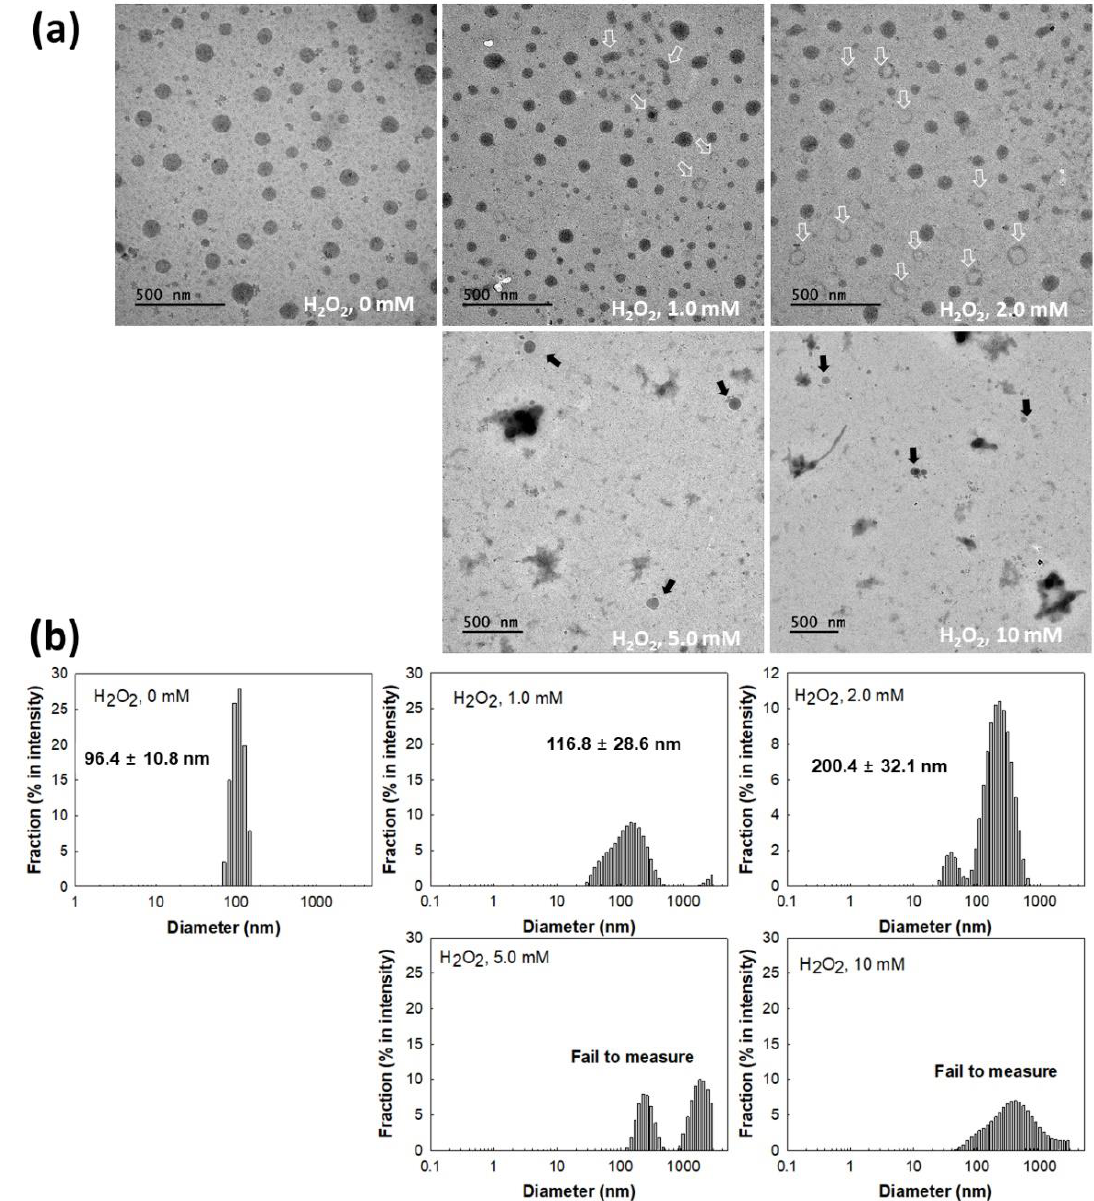
Figure 4. ( a ) H 2 O 2 effect on the changes of nanophotosensitizer morphologies. ( b ) H 2 O 2 effect on the size distribution changes of nanophotosensitizers.